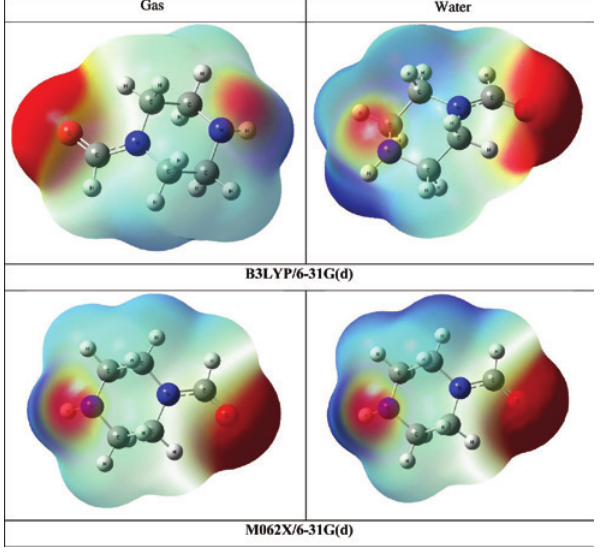
Figure 1: Electrostatic potentials on 1-fp. Surfaces are defined by the 0.0004 electrons/b 3 contour of the elec- tronic density. Color ranges, in a.u.: blue: more positive than 0.032 and red: more negative than –0.032.